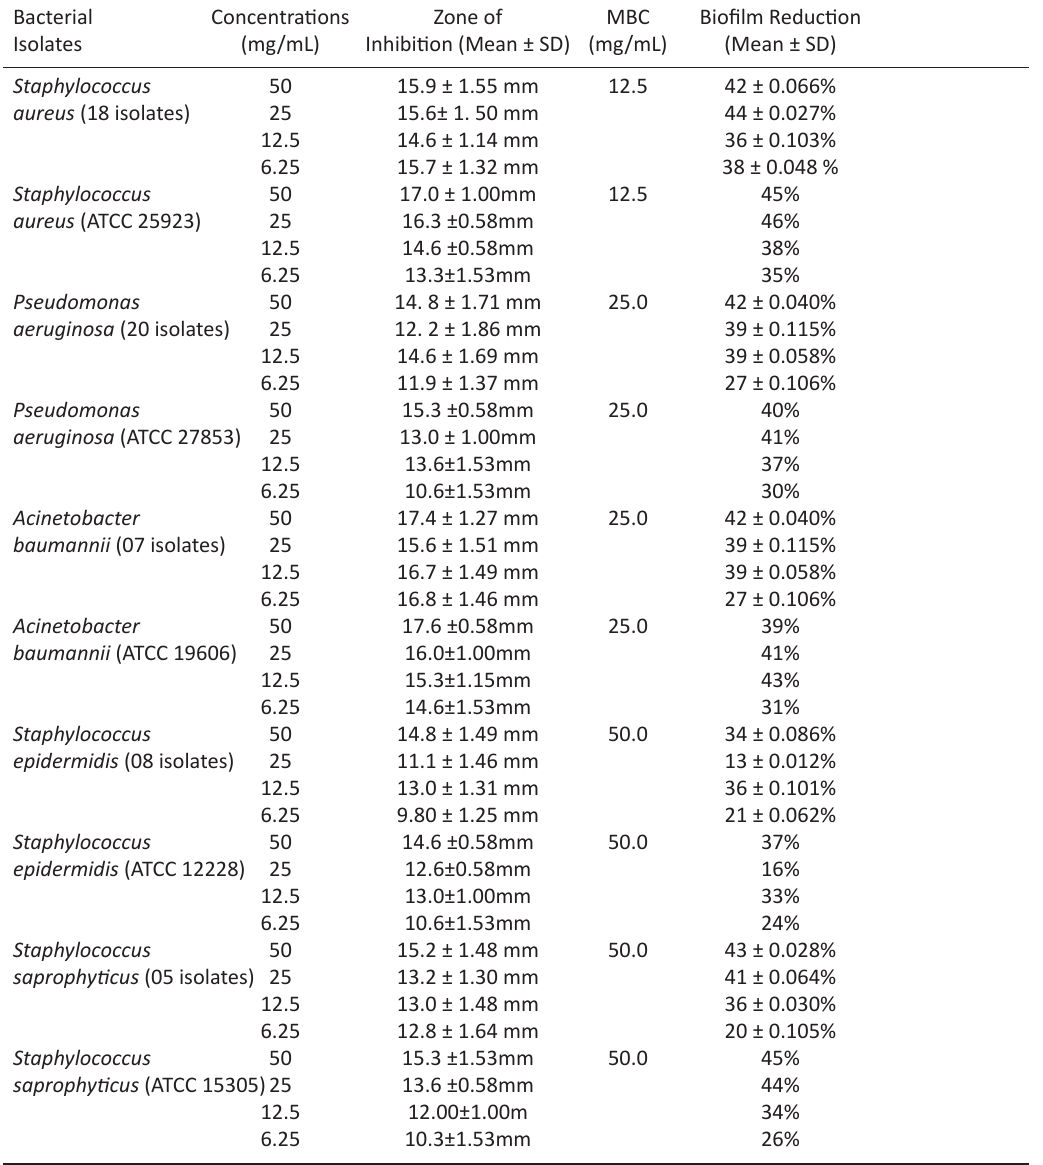
Table 5. Antibacterial and antibiofilm activity of Coriandrum sativum Bacterial Concentrations Zone of Biofilm